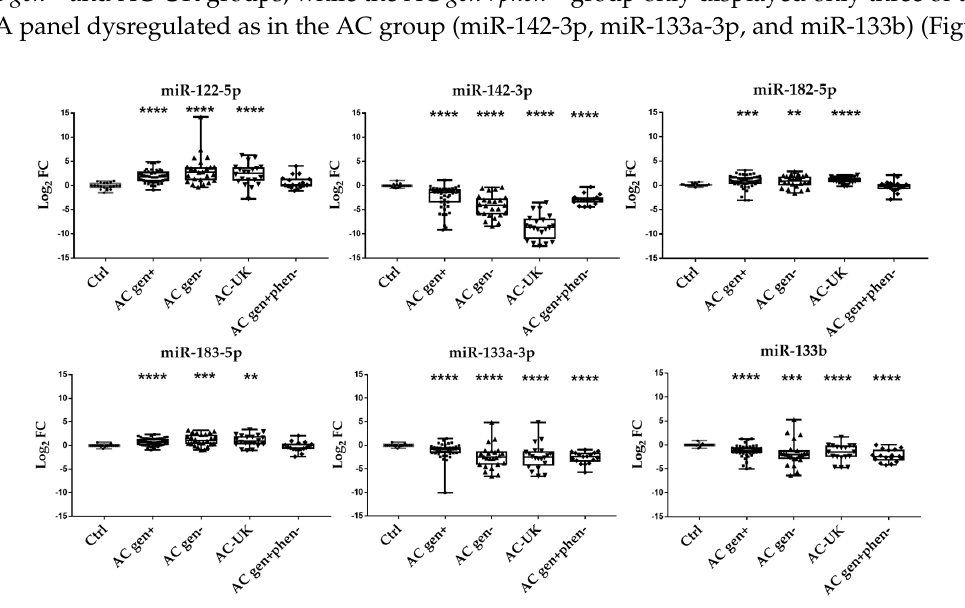
Figure 2. Box and whiskers plots and p values of the 6 significant DE miRNAs on the AC cohort: 46 AC gen+, 24 AC gen-, 20 AC-UK and 17 AC gen+phen − cohorts vs 20 ctrls (p value calculated by Mann-Whitney test, each group separately vs. ctrl: **** < 0.0001, *** < 0.001, ** < 0.01, * < 0.05).